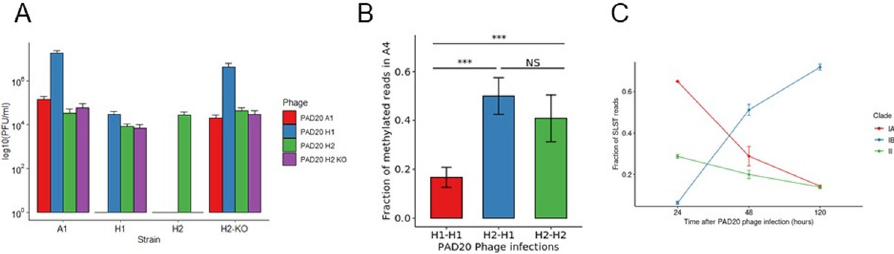
Fig 2. R-M system IIIB of C . acnes KPA171202 affects PAD20 Phage infection properties and protects the bacteria from lysis. - (A) Variation of infection properties of PAD20 phage propagated on either SLST A1, H1, H2 or H2 KO. (B) Fraction of methylated reads in the methylated adenine at 4th position of the AGCAGY motif in the PAD20 phage genome. Samples are named first after the infected strain where the phage was sequenced and second after the strain on which the phage was previously propagated (i.e, H2-H1 means a phage produced in H1 was used to infect H2 and then extracted for sequencing from H2) Significance was tested using ANOVA analysis ( ��� , p < 0.001). (C) Selected killing of whole microbiome samples infected with PAD20 propagated on SLST A1 after 3 different time points. Samples were taken after 24, 48, 120 h of on-going PAD20 infection. Samples were amplified using SLST methodology and subjected to Illumina sequencing. Similarity to SLST alles is used to classify sequencing reads into clades IA, IB and II. Clade IA contains following SLST types: A1, A2, A3, A4, A7, A11, A13, A16, A17, A18, A21, A24, A27, A28, A29, A30, A31, A33, A34, A35, A38, A40, A42, A46, A47, A48, A49, A51, A52, C1, C5, F4, F6, F10, F15, F16, F17, F22, F24; Clade IB contains: H1, H2, H3, H4, H7, H8, H10, H11, H12; Clade II contains: K1, K2, K7, K9, K17,